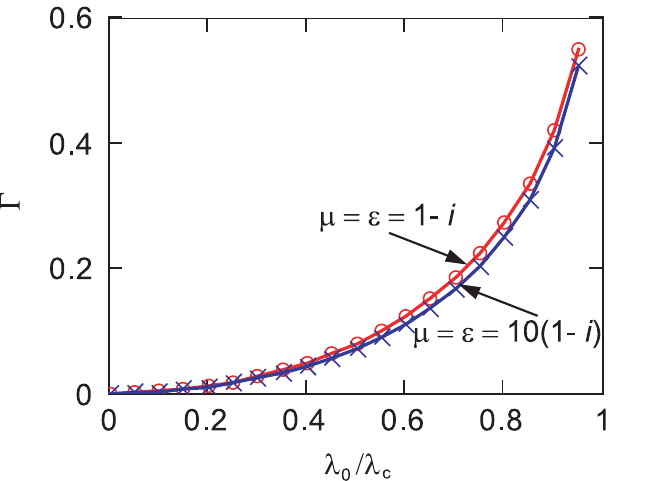
FIG. 20. A half-cavity with a disk shape load at the end of the beam pipe for the data presented at Fig. 21 and a dipole mode with high Q ext